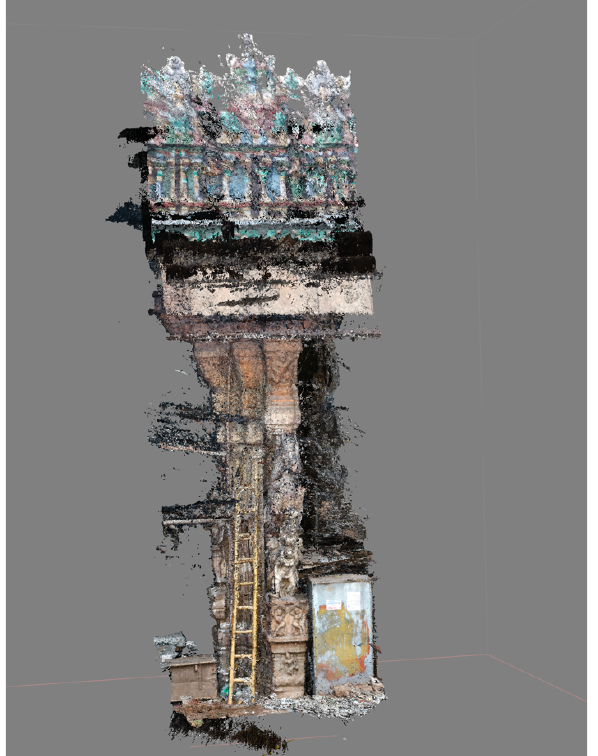
Figure 10. Pointcloud of the Horseman pier on the West front of the Pudhu Mandapam that is internally Ardhanarisvara derived from traditional photogrammetry using © Agisoft Figure 12. Mesh generation for the Horseman pier on the East Metashape elevation that is internally Sundaresvara as a sow feeding her piglets using ©